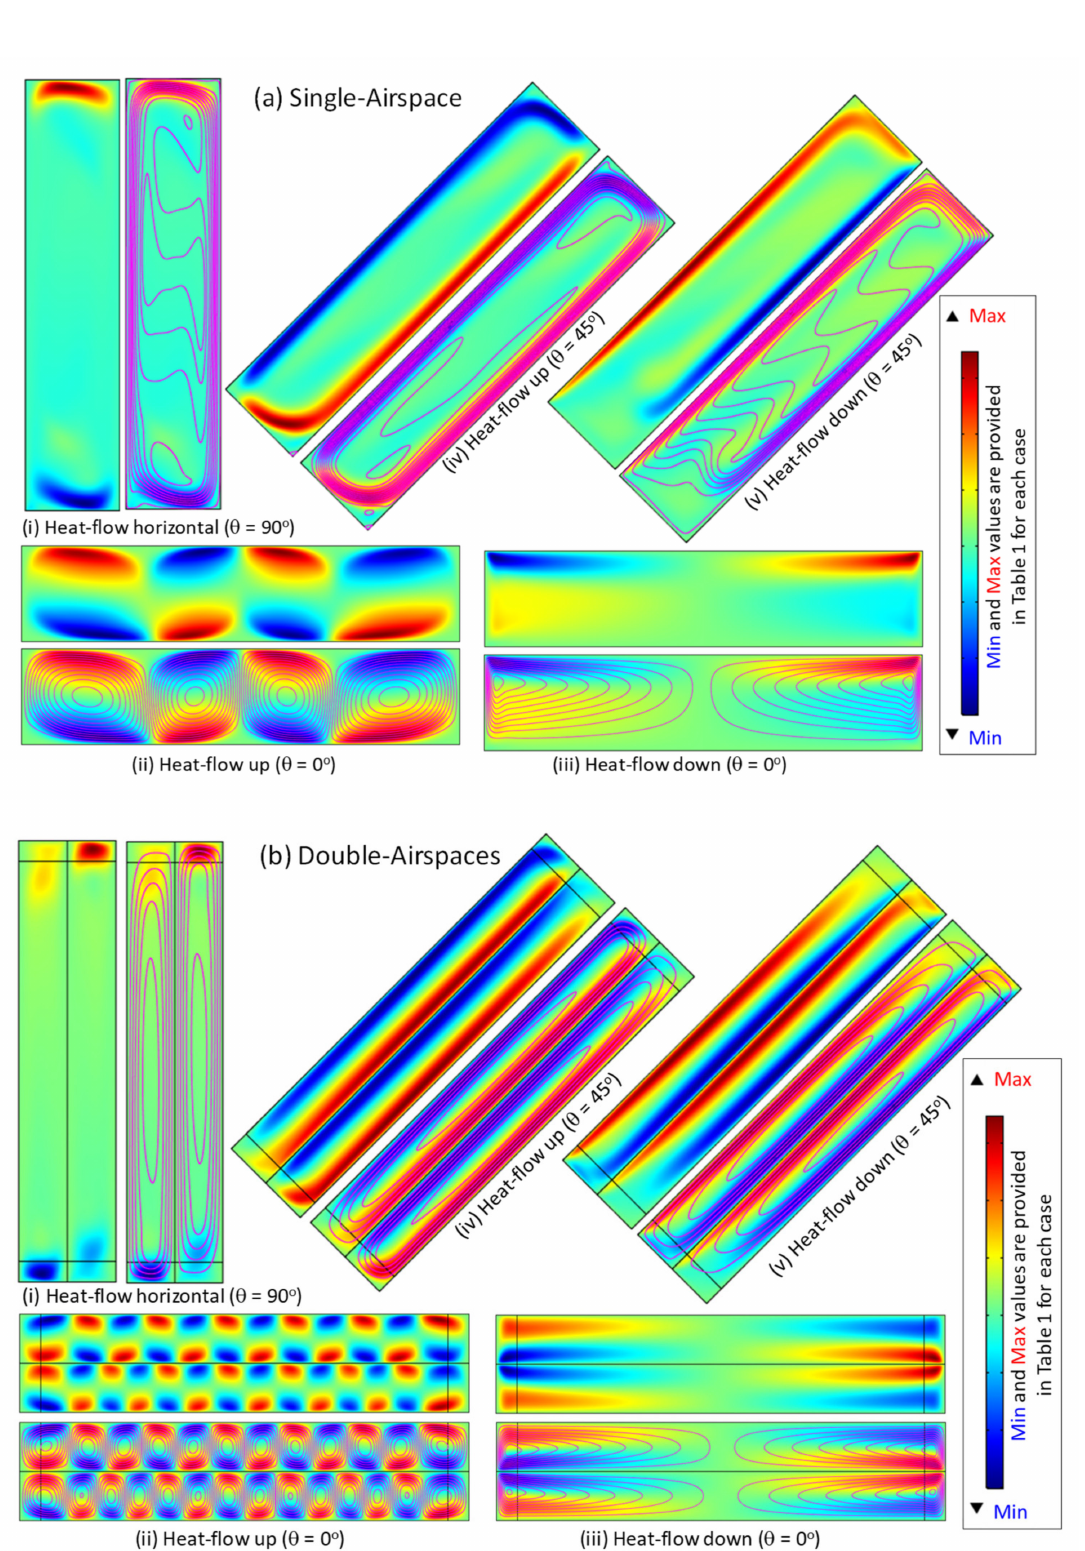
Figure 5. Distributions of horizontal velocity and velocity field streamlines in ( a ) a single airspace and ( b ) double airspaces (H = 406 mm (16 inches) and δ = 89 mm (3.5 inches), T H = 32.2 ◦ C (90 ◦ F), T L = 15.6 ◦ C (60 ◦ F), E =